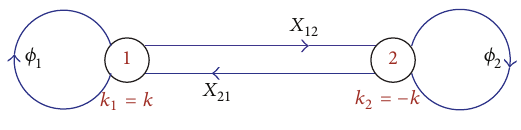
Figure 3: Quiver diagram (c).